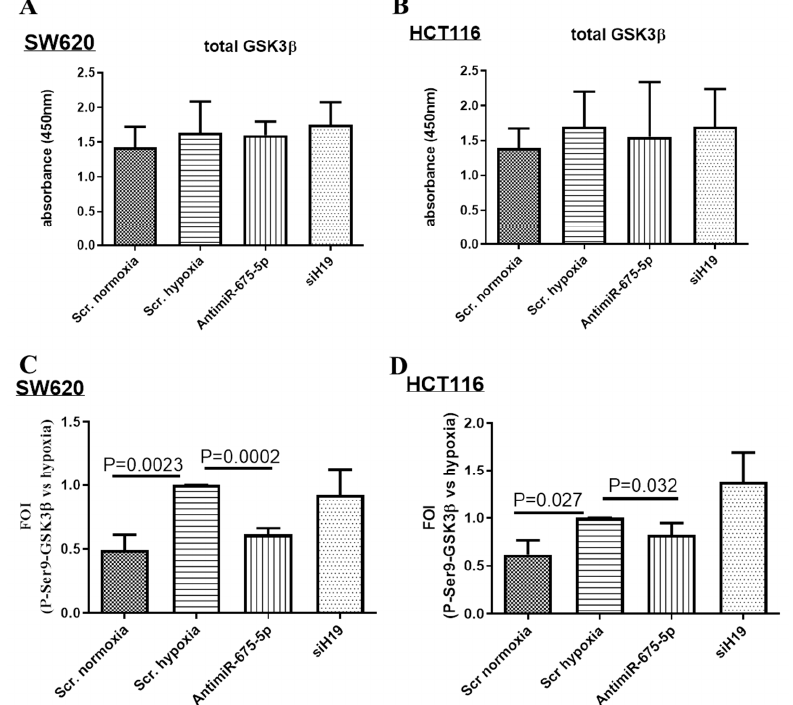
Figure 5. MiR-675-5p inhibition favors GSK3 β activation in hypoxic cells. Total GSK3 β assay in SW620 ( A ) and HCT116 ( B ) transfected with AntimiR-675-5p, siH19 or relative negative control and subjected to 18 h of hypoxic stimulation, or transfected with the scrambled negative control and maintained in normoxic condition. Data are expressed as absorbance (ABS) values at 450 nm, and are represented as the mean ± SD of three independent experiments. Total / P-Ser9-GSK3 β ELISA assay in SW620 ( C ) and HCT116 ( D ) treated as described above. Data of P-Ser9-GSK3 β were normalized for total GSK3 β and expressed as fold of increase (FOI) with respect to the P-Ser9 GSK3 β levels in hypoxic cells transfected with scrambled negative control. Data are expressed as the mean ± SD of three independent experiments and p -values indicated in the